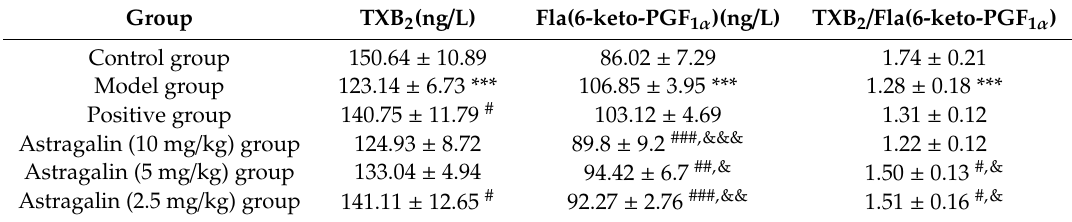
Table 6. E ff ect of astragalin on TXB 2 and 6-Keto-PGF 1 α (X ± SD, n = 8). Table 6. Effect of astragalin on TXB 2 and 6-Keto-PGF 1 α (X ± SD, n = 8).